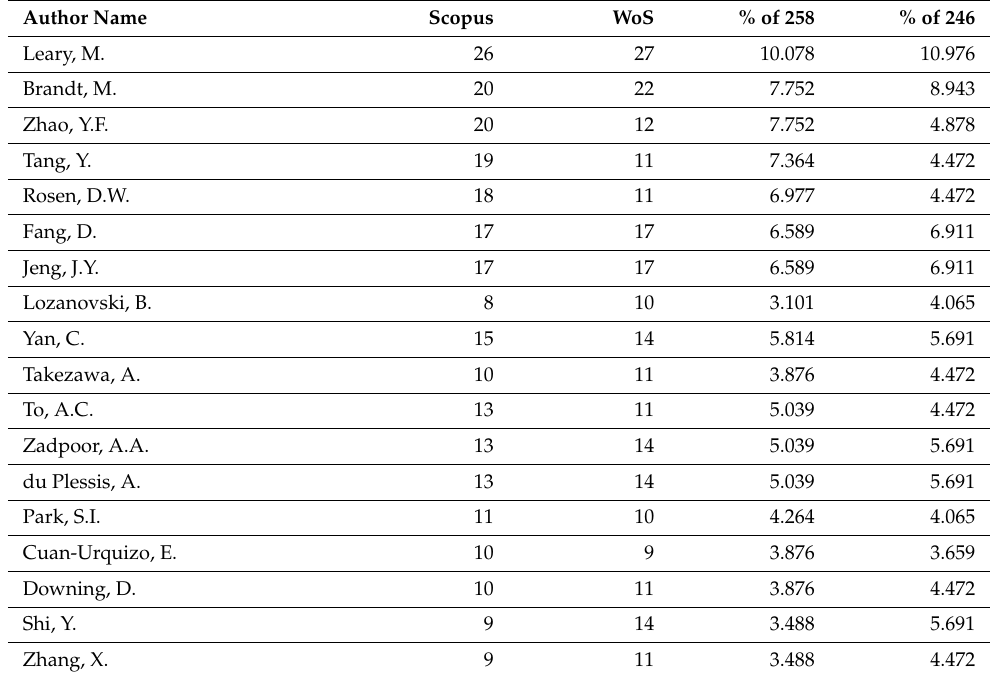
Figure 17. Publication authors for “additive manufacturing on lattice structure” research (data retrieved from Scopus and WoS on 20 June 2022). Table 4. Comparative results on publication authors for “additive manufacturing on lattice structure” research (data retrieved from Scopus and WoS on 20 June 2022).